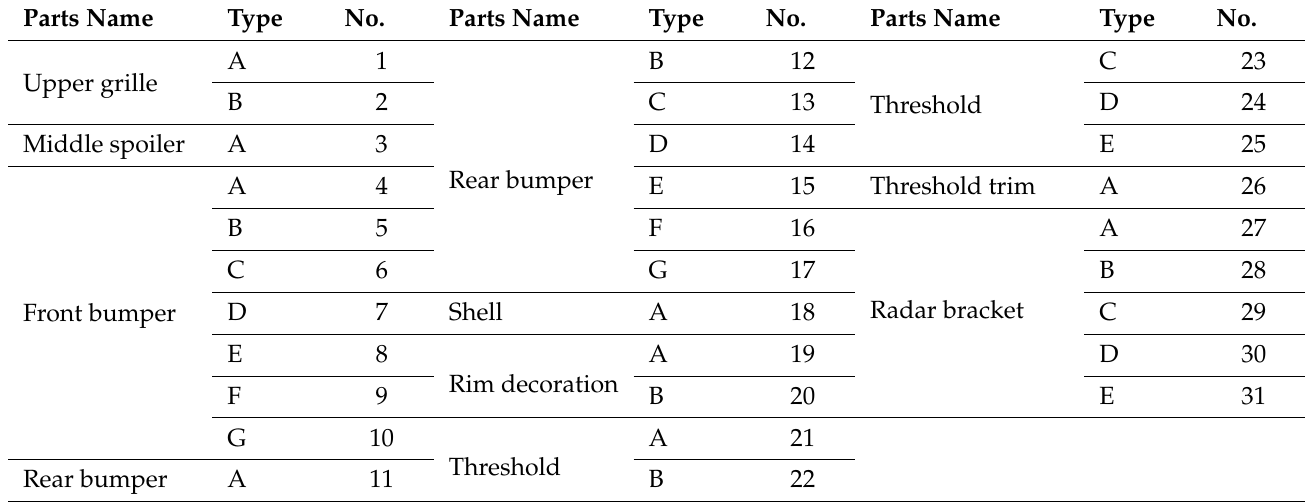
Table A1. All types of